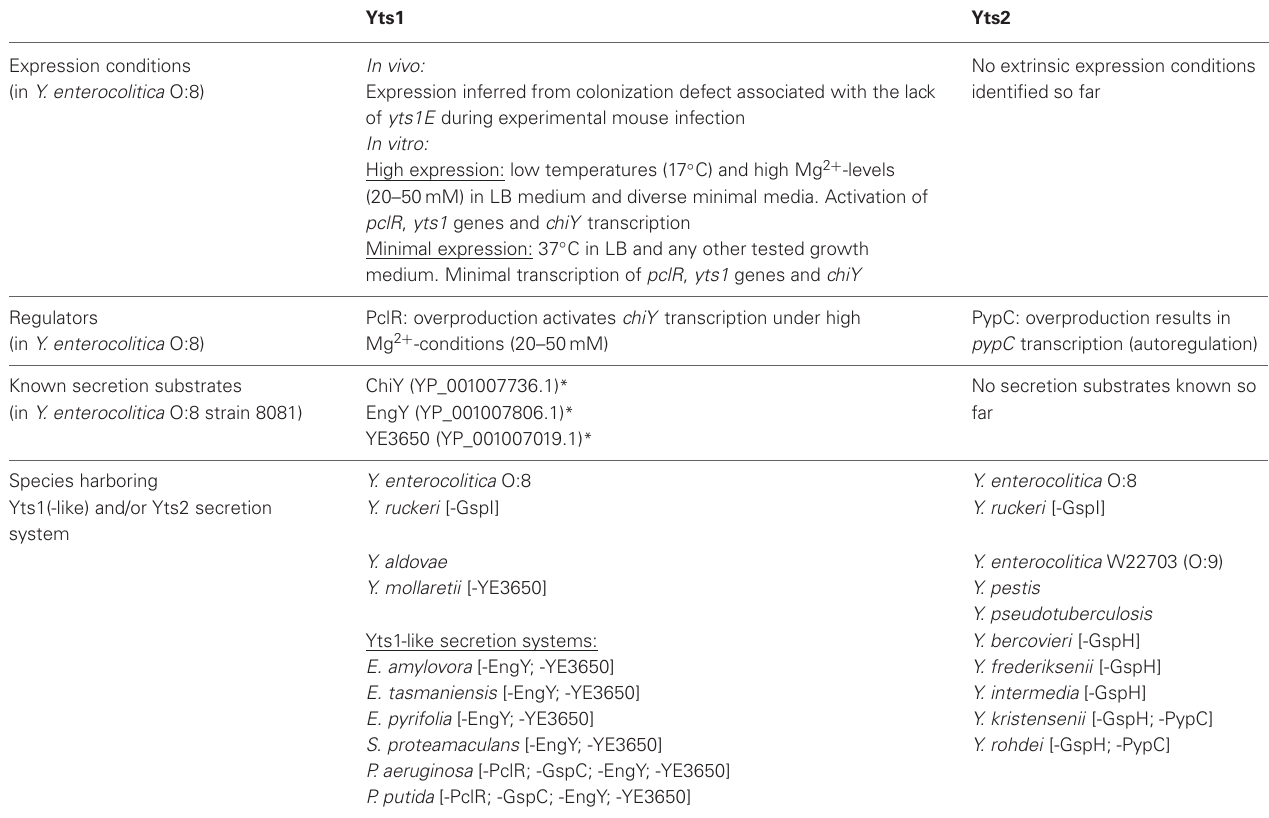
Table 1 | Occurrence of Yts1(-like) and/or Yts2 secretion systems and corresponding substrates in Yersinia and other bacterial species. Yts1